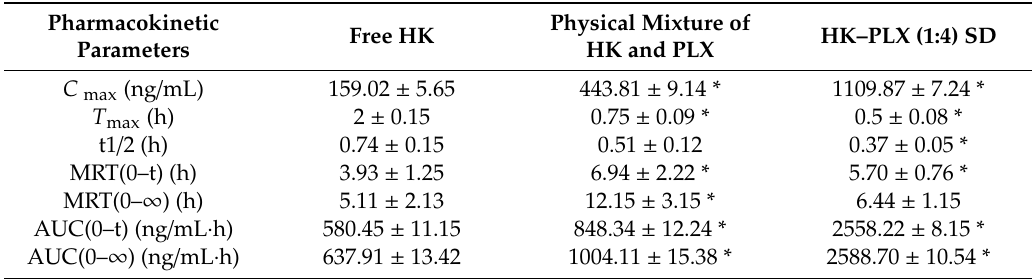
Figure 9. The bioavailability result of the free HK, the physical mixture and the HK–PLX (1:4) SD Data are presented as the mean ± standard deviation ( n = 6). * P < 0.05 vs. free HK. Table 1. Pharmacokinetic parameters for HK in rats after oral administration of free HK, physical mixture of HK with PLX, and HK–PLX (1:4) SD. Data are presented as mean ± standard deviation ( n = 6). * P < 0.05 (vs. free HK).